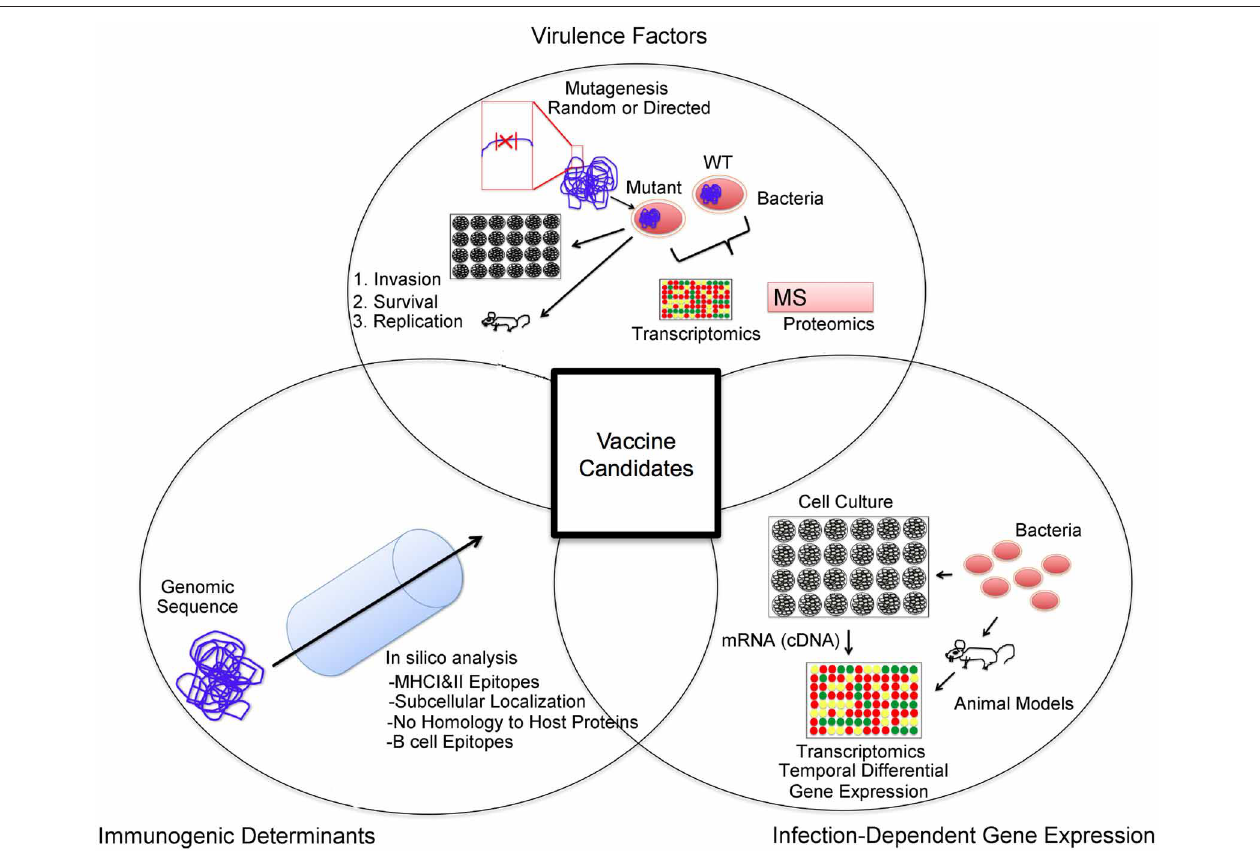
FIGURE 2 | Vaccine candidate selection approach. An important aspect of a vaccine candidate is antigenicity. In silico analysis of available genomic sequences can aid in the selection of open reading frames that code for desired properties such as T and B cell epitopes, subcellular localization (i.e., outer membrane proteins), and a lack of homology to host proteins. Secondly, antigens with evidence for a role in pathogenesis are often targeted in the identification of vaccine candidates. Identification of